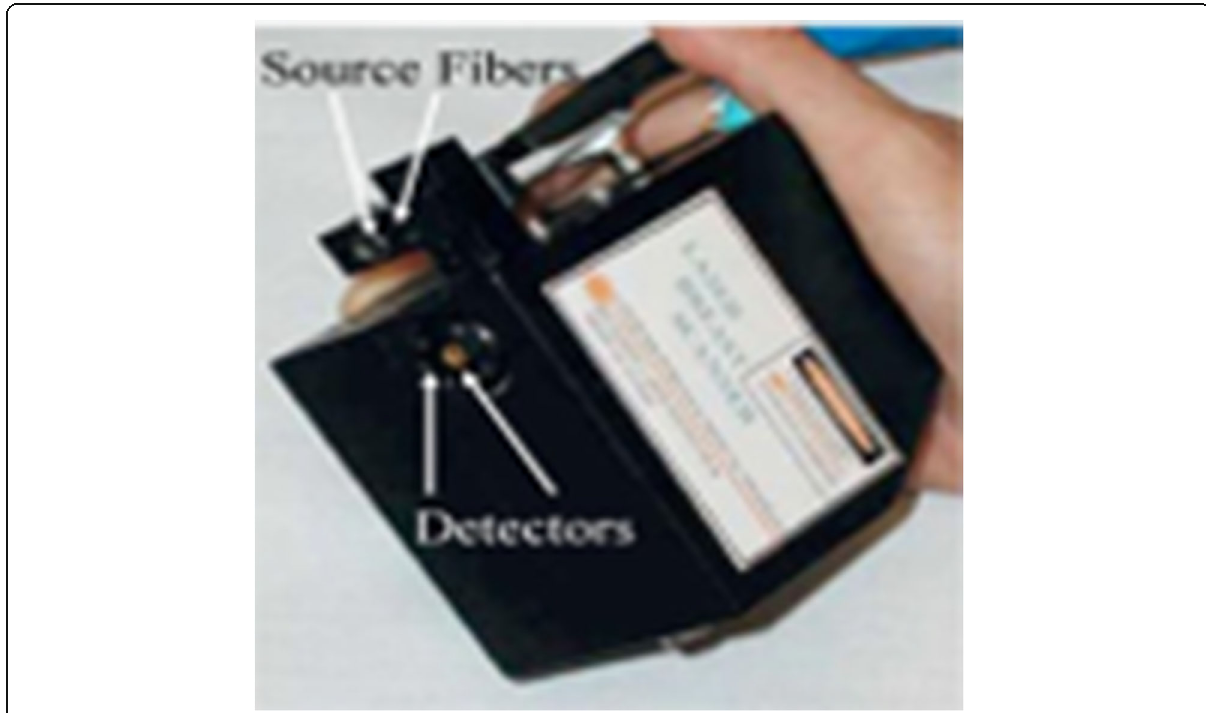
Fig. 22 Optical imaging method with hanging breasts